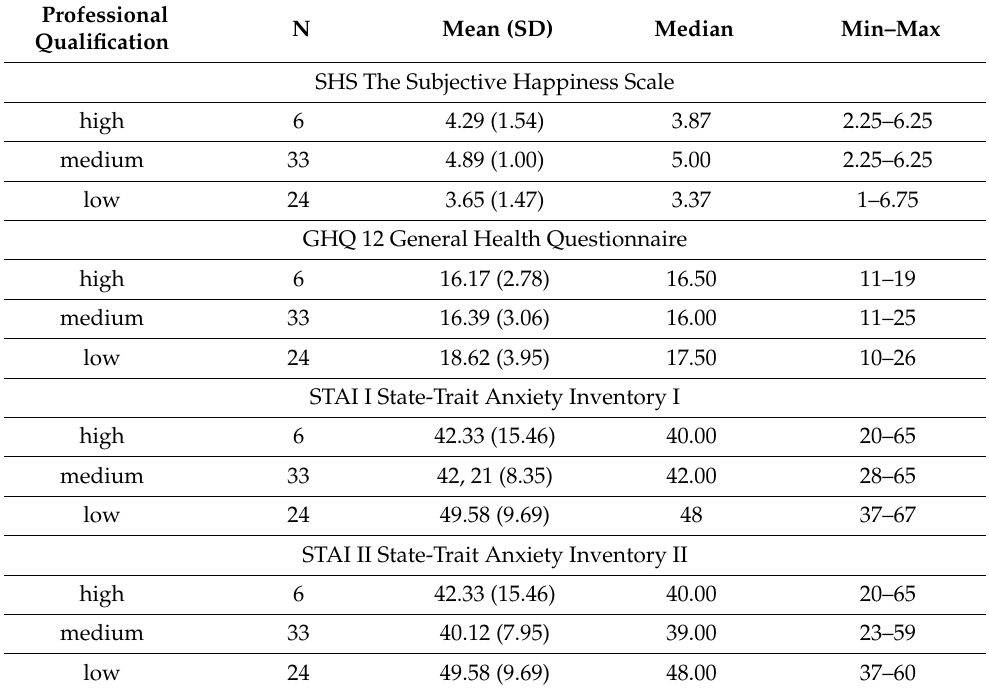
Table 7. Mean standard deviation, median, minimum and maximum of SHS, GHQ 12, STAI I and STAI II values in the groups of anaesthetists differentiated with respect to the assessment of their professional